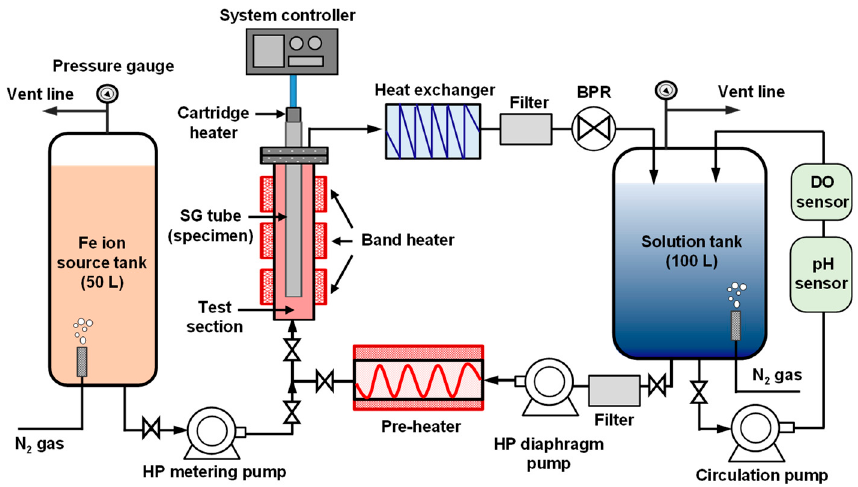
Figure 1. Schematic of the magnetite deposition loop system.